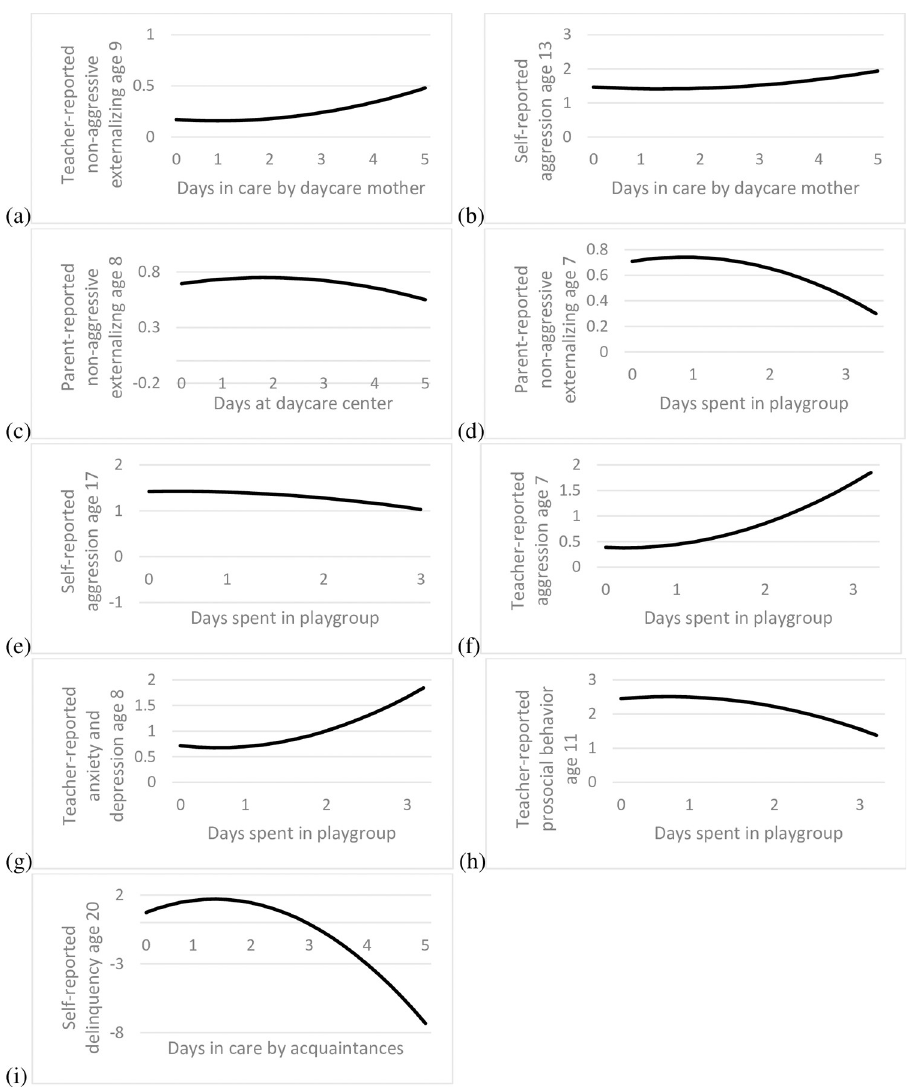
Fig 2. Examples of curvilinear relations between time spent in external childcare and social